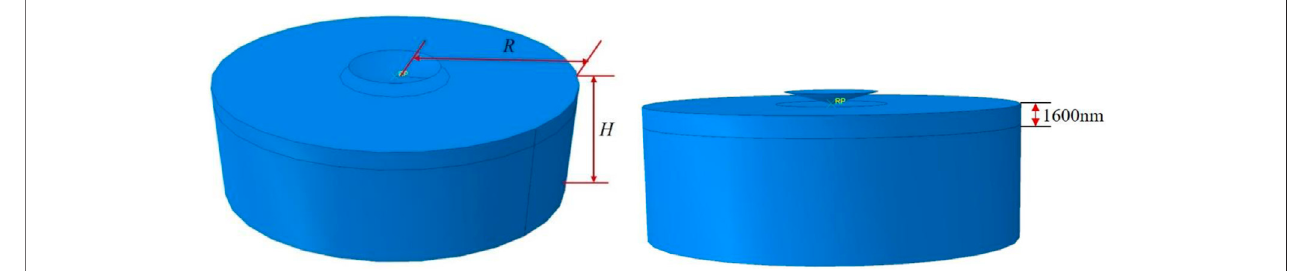
FIGURE 7 | Model for the nanoindentation experiment.